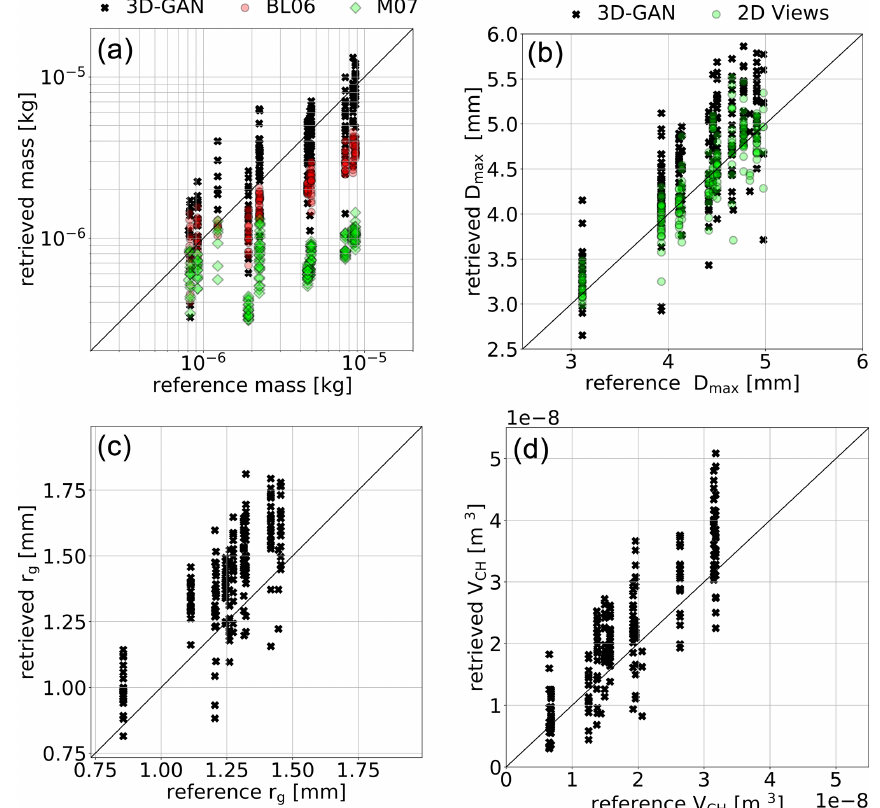
Figure 3. Scatterplot of reference (3D-printed replicas) and reconstructed characteristics of the snowflakes used in the evaluation. (a) Mass, (b) D max , (c) r g and (d) V CH . For the mass we display 3D-GAN reconstructions as well as mass–size reconstructions by Matrosov et al. (2007) (denoted ML07) and Baker and Lawson (2006) (denoted BL06). M07 and BL06 are calculated on individual MASC views, and the mean value over the three views is shown here in each marker. For D max , the estimation obtained using the 2D MASC images is highlighted in